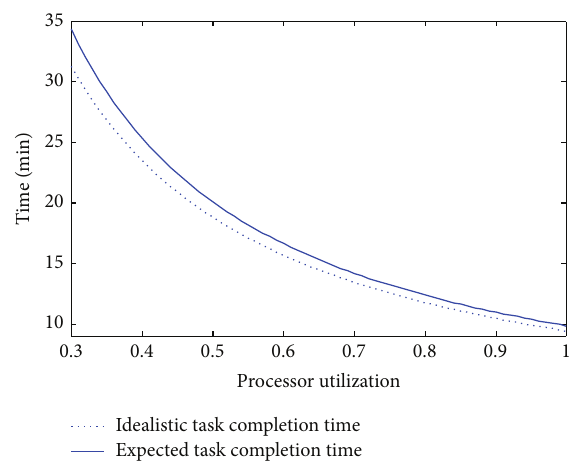
Figure 3: Relationship between task completion time and processor